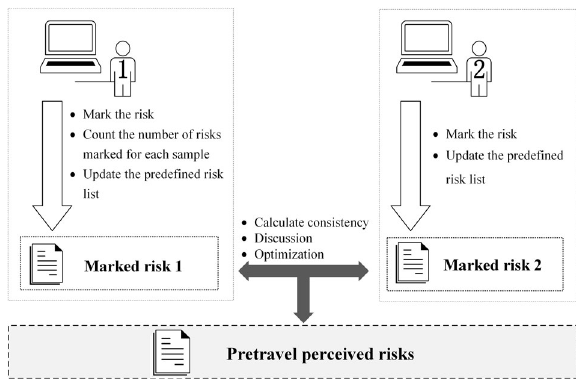
Fig. 3 Risk label process. It visually demonstrates the manual labelling process of pretravel risk perception results.